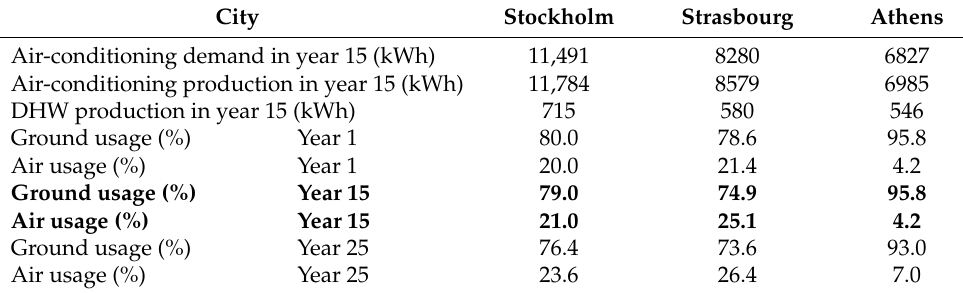
Table 11. Energy demand vs. energy production and percentage of the thermal source